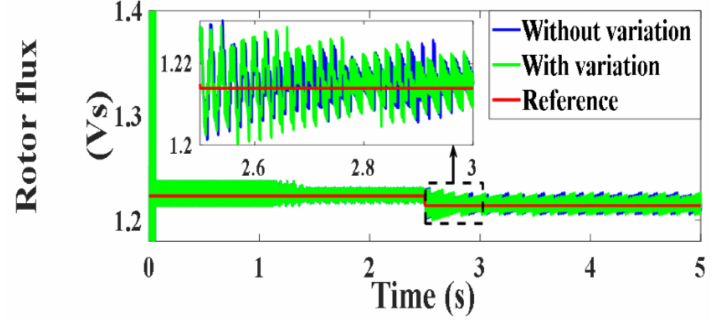
Figure 76. Rotor flux under PVC (Vs).